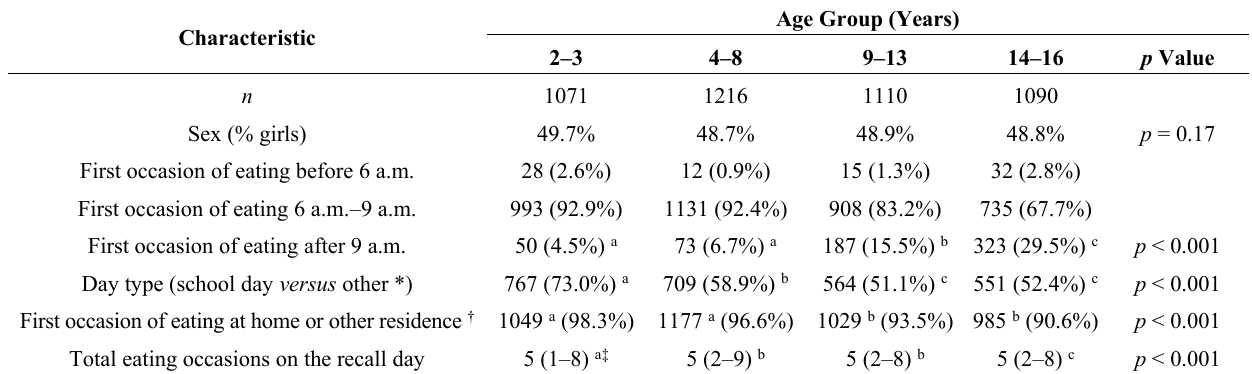
Table 1. Characteristics of subjects and their first occasion of